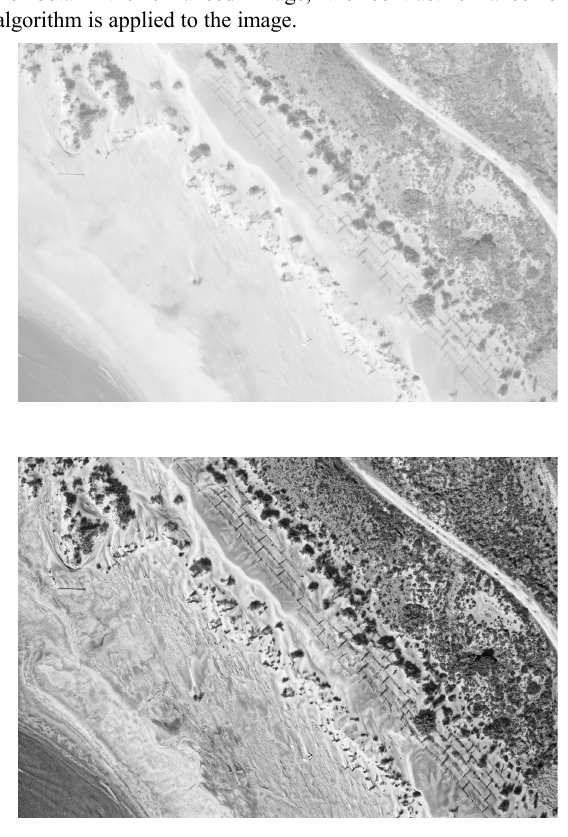
Figure 2. Same image before and after enhancement